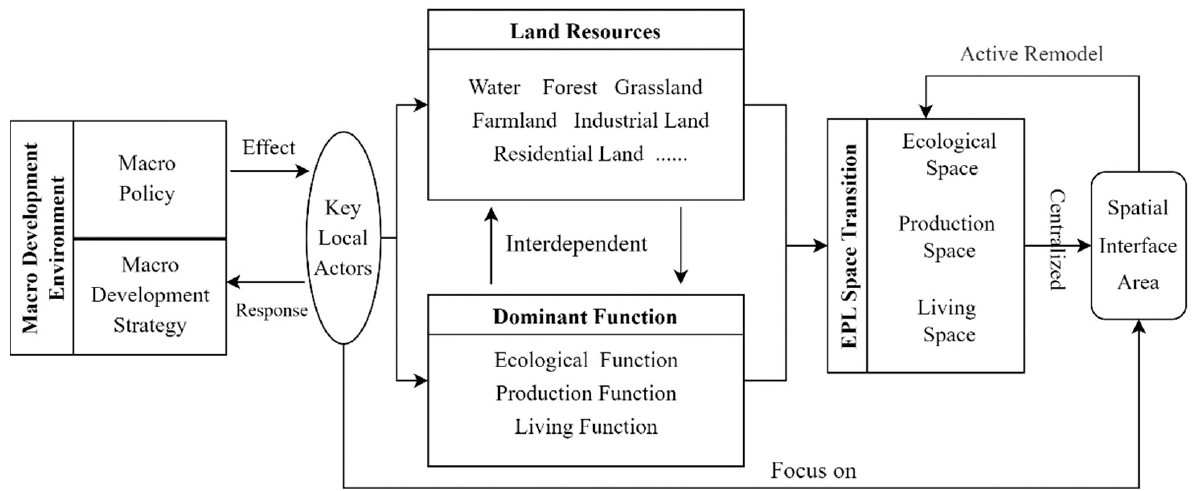
Figure 1. Diagram of the theoretical framework.